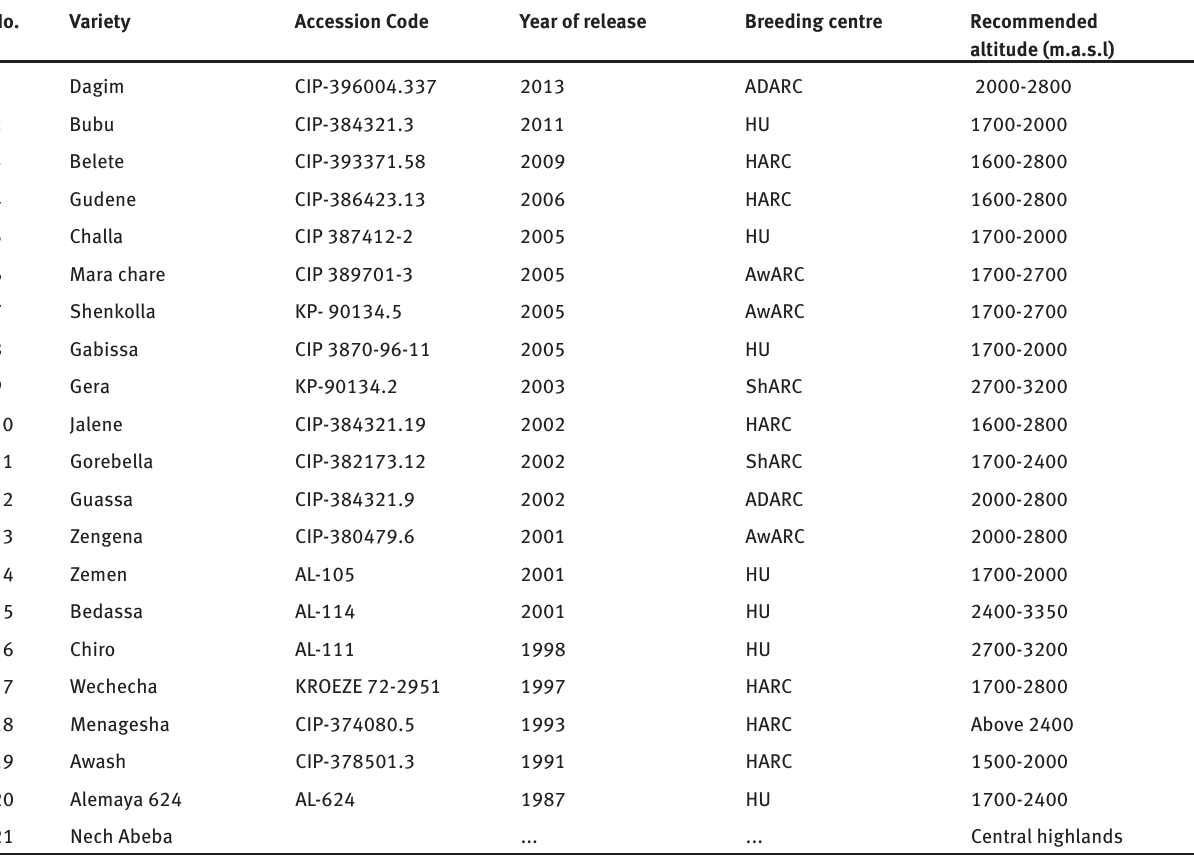
Table 2: List of experimental materials included in the study No.